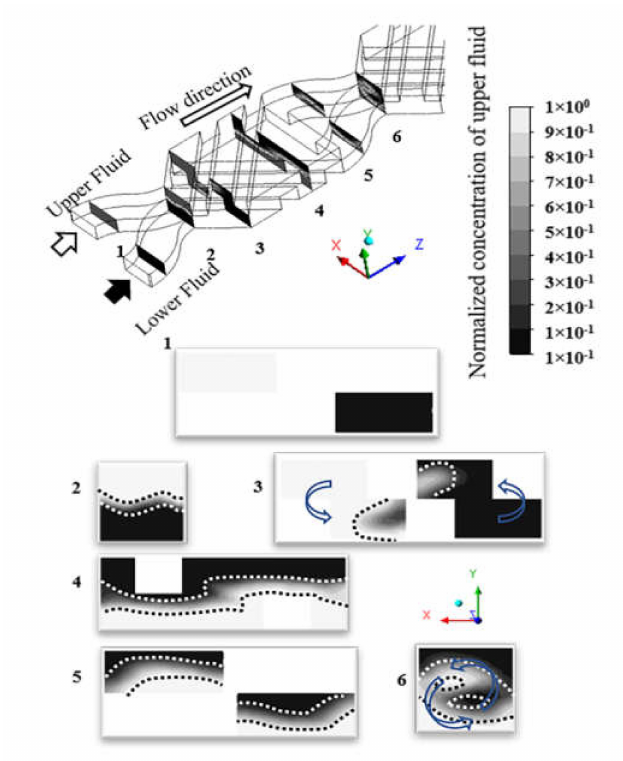
Figure 2. Schematic diagram of design concept with procedures of fluid mixing illustrated through mixing